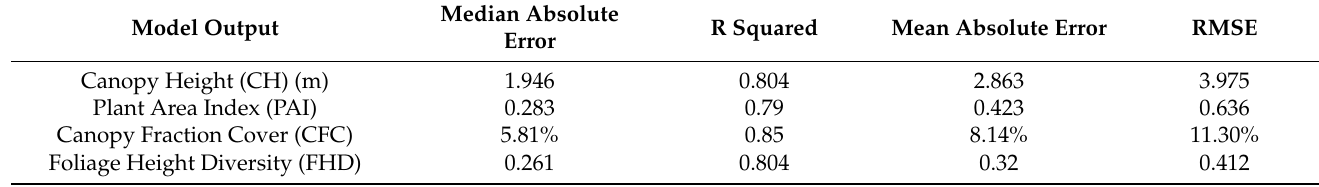
Table 11. Overall assessment of the VIIRS products accuracy using the collocated ALS-derived data for the period 2013–2020.